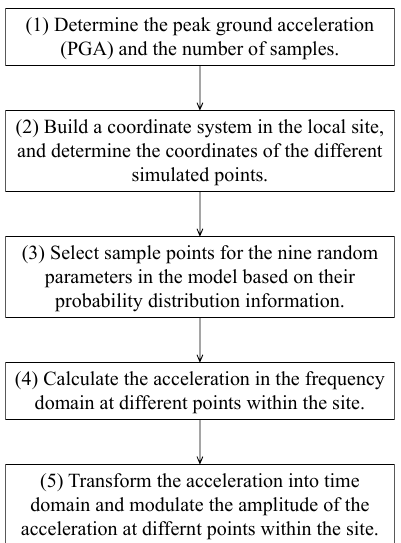
Figure 19. Flowchart to show the application of the proposed model.